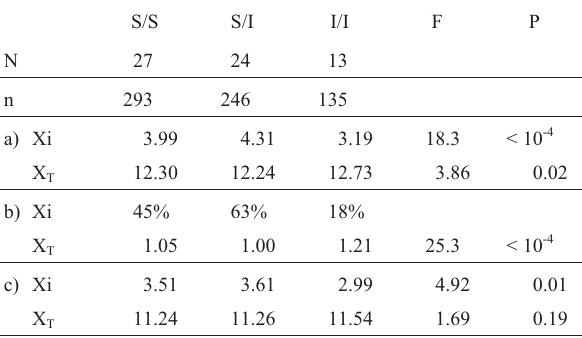
respectively) (Figure 2). Table 2 - Interstitial (Xi) and total (XT) chiasmata frequencies in different M4 inversion karyomorphs of Sinipta dalmani from the “Los Loros” pop- ulationand“F”statisticsvaluesforthecomparisonofaveragesamongdif- ferent karyomorphs. a) mean frequencies, b) frequencies in M4 pair, c) frequencies without M4 data. S/S: standard homozygotes, S/I: heterozy- gotes, I/I: inversion homozygotes. (N: number of analyzed individuals; n: number of analyzed cells).